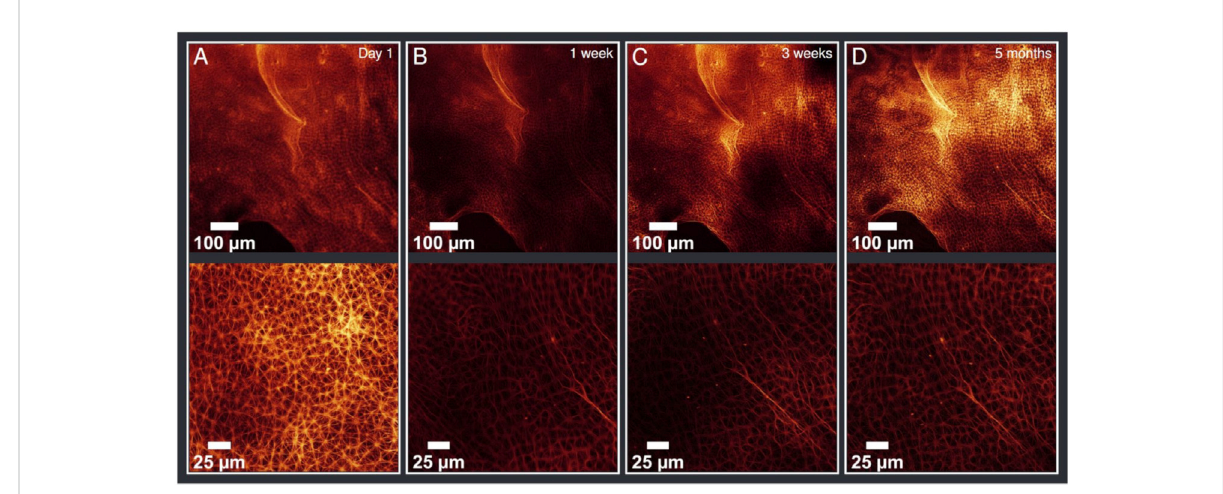
FIGURE 3 Evolution of the sample ordered by date with different magni fi cations (upper line ×20, lower line ×63 magni fi ed). (A) taken on day 1 (B) after 1 week (C) after3 weeks (D) after5 months.Therearenodifferencesvisibleinthistimeevolution(onday1adifferentmagni fi edsectionwasimaged) demonstrating the stability of the aster network structure. According values of the analysis are given in Table 1.